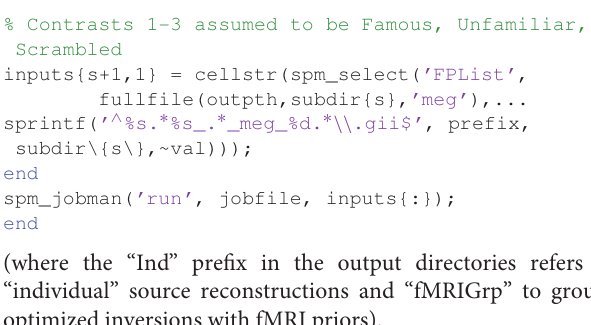
% Contrasts 1-3 assumed to be Famous, Unfamiliar,